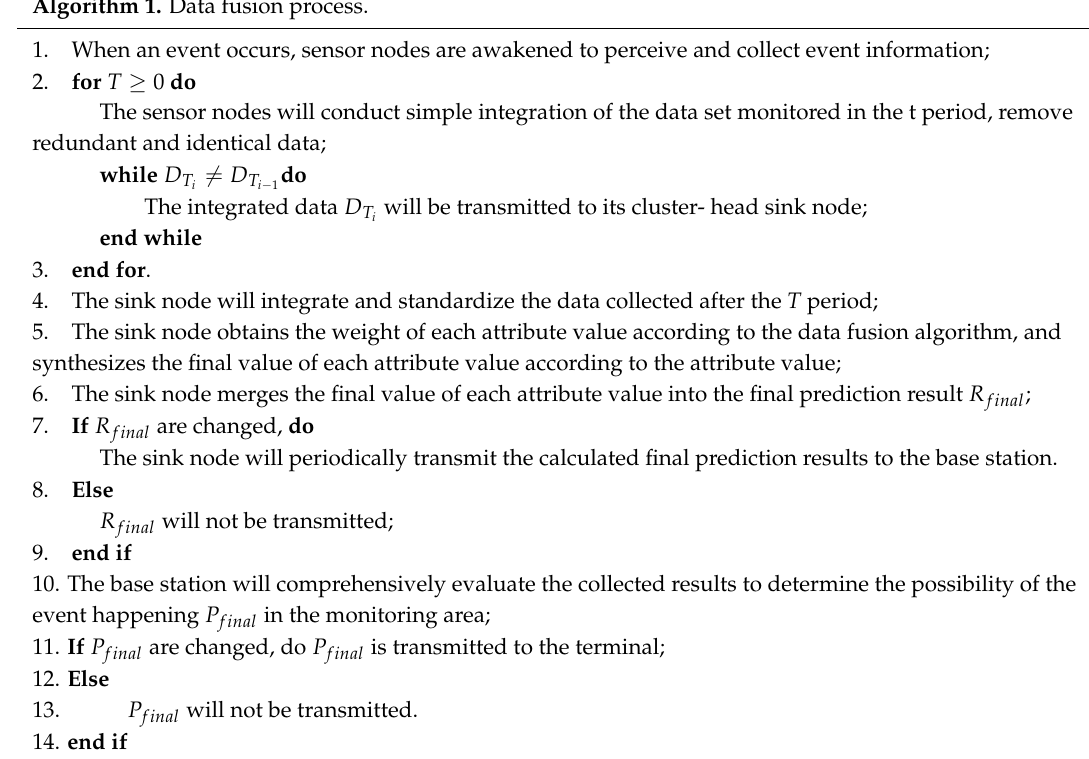
Algorithm 1. Data fusion